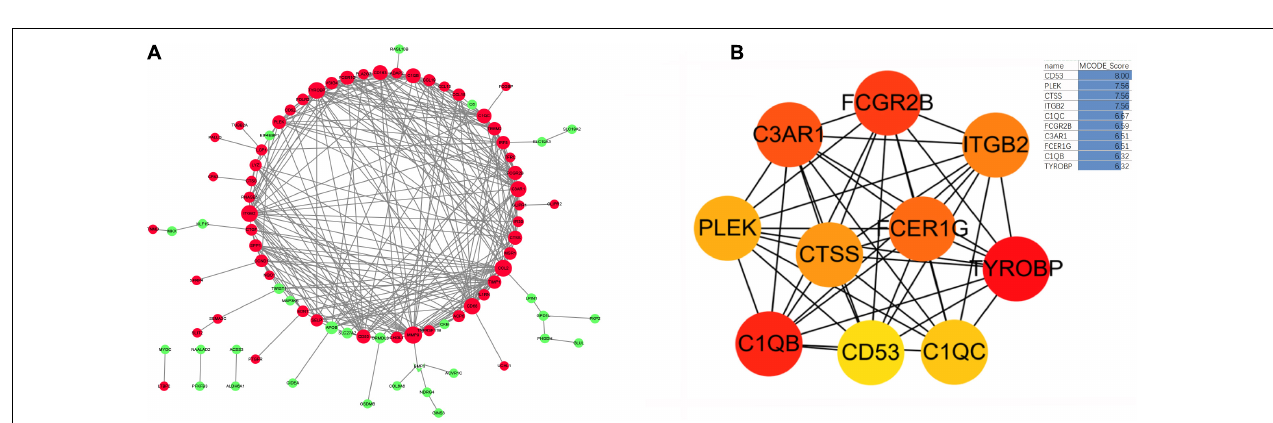
FIGURE 5 | (A) Enrichment of upregulated differentially expressed genes in gene ontology (GO); (B) enrichment of downregulated differentially expressed genes in GO, different colored circles indicate different adjusted P -values. The size of the circle indicates the gene count. The Y -axis represents the GO term, the X -axis represents the gene proportion. (C) Enrichment of upregulated differentially expressed genes in KEGG, X -axis represents gene count, Y -axis represents different pathways, and different colors indicate different adjusted P -values; (D) enrichment of downregulated differentially expressed genes in KEGG.